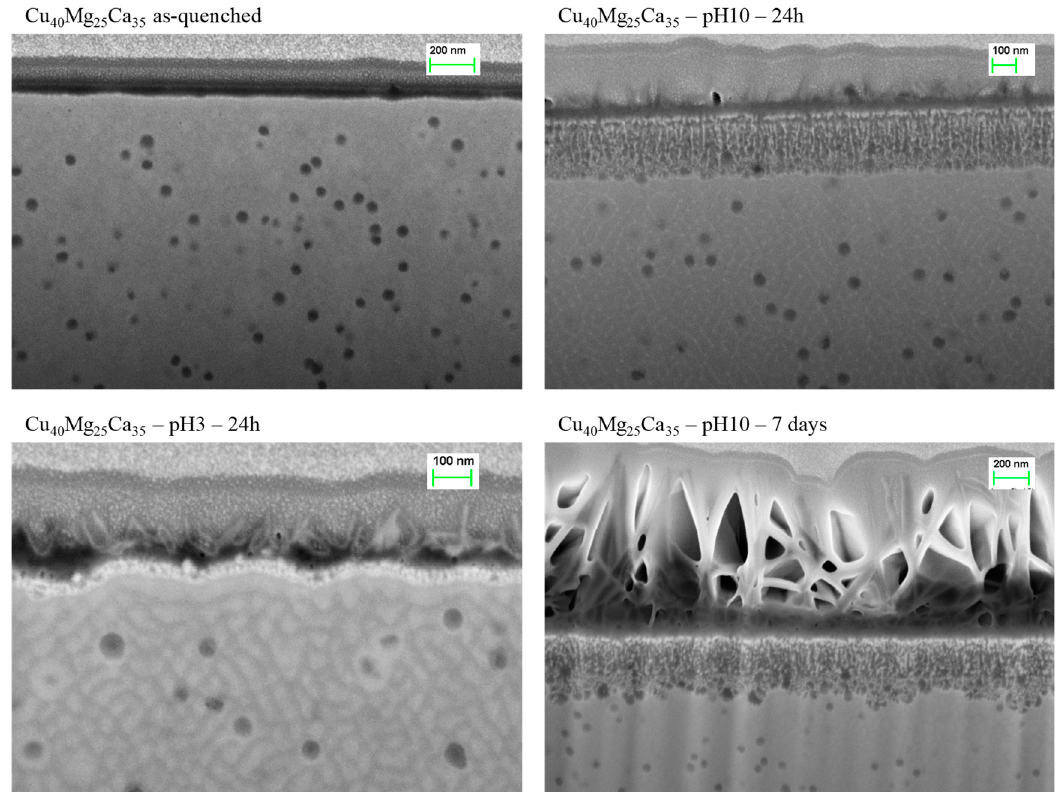
Figure 10. SEM images of transversal cuts of Cu 40 Mg 25 Ca 35 in the initial state ( left - top ) and dealloyed by immersion in pH = 3 and pH = 10 solutions.